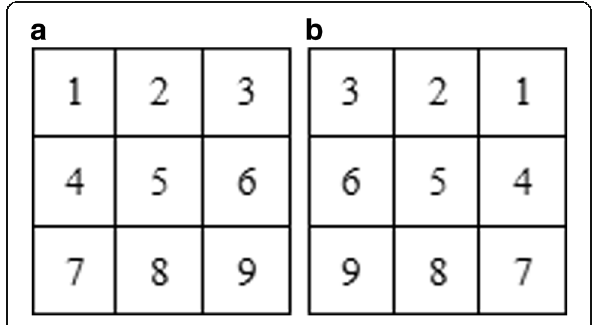
Fig. 8 3 × 3 exemplar patch and damaged patch. a Exemplar patch Ψ p P 2 center on 2 . b Damaged patch